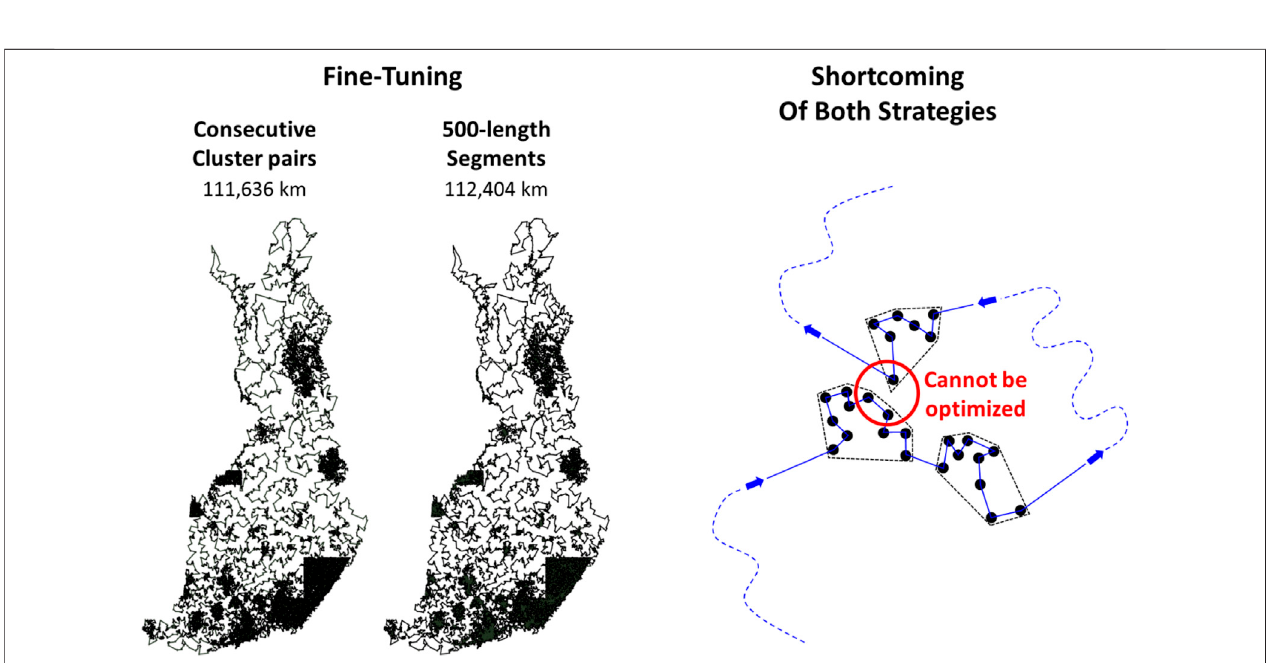
FIGURE 20 | Result of fi ne-tuning using two techniques and an example where optimization is not possible using either of the two techniques.